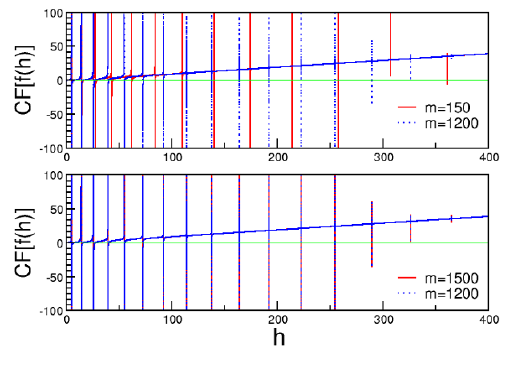
Figure 5. Plot of the continued fraction CF [ f ( h )] for n = 10 spikes. In the upper (cid:12)gure the red curve is for m = 150 and the blue is for m = 1200. In the lower (cid:12)gure the red curve is for m = 1500 and the blue one is for m = 1200.